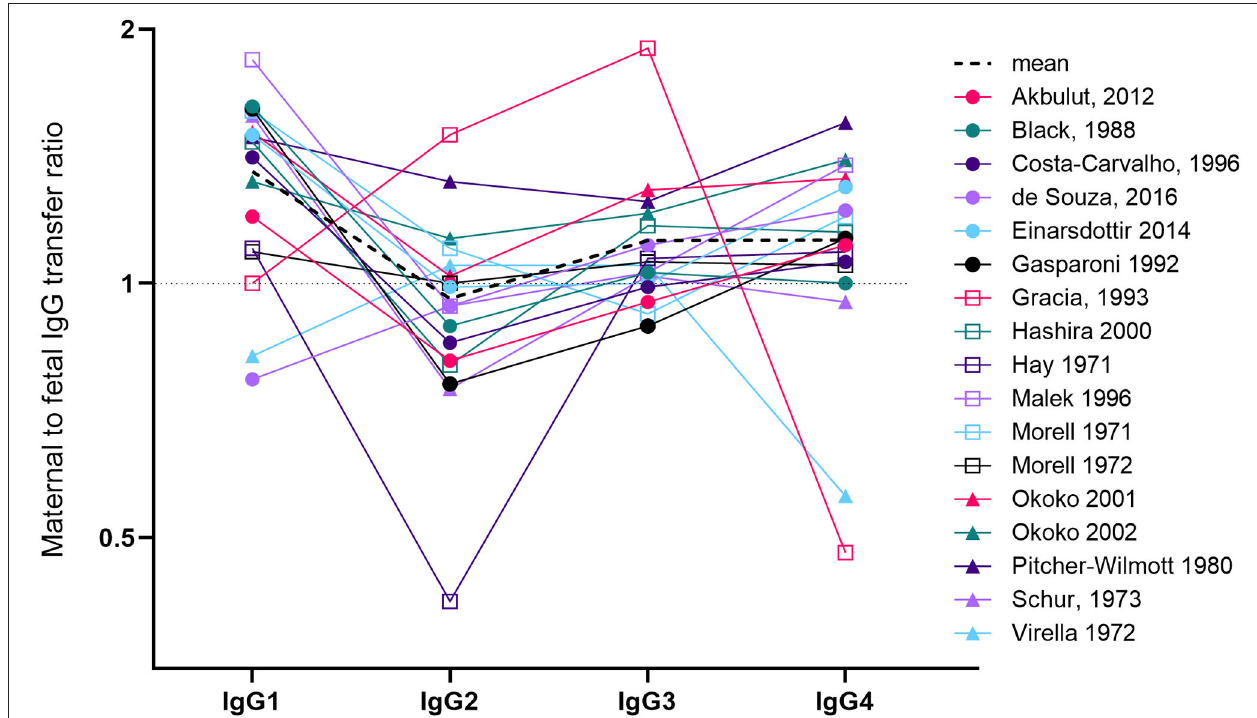
FIGURE 1 | Overview of studies investigating maternal to fetal transfer ratios of IgG subclasses. We identified 17 papers that measured paired maternal and cord levels of all four IgG subclasses (13–22, 24–29). Studies had either employed radioimmunoassay, immunodiffusion, laser nephelometry or ELISA. The line graph represents the mean to fetal transfer ratio on a log(2) axis. Levels > 1 (above the dotted line) indicates higher levels in cord blood compared to maternal blood. The dotted black line indicates the mean of the 16 studies. For Malek et al. (29) we only used the values from term pregnancies (37–41weeks). For two studies, we performed ratio calculations based on reported maternal and cord concentrations (21, 29). For two other studies, values were calculated by reading from the published graphs ( 13, 15). For Costa-Carvalho et al. (13) this required us to read the ratios from the summary graph produced in the review by Palmerio et al. (12). In Hay et al. (28), the maternal levels of IgG1 were the lowest of all the other subclasses and maternal IgG2 was the highest (double the level of